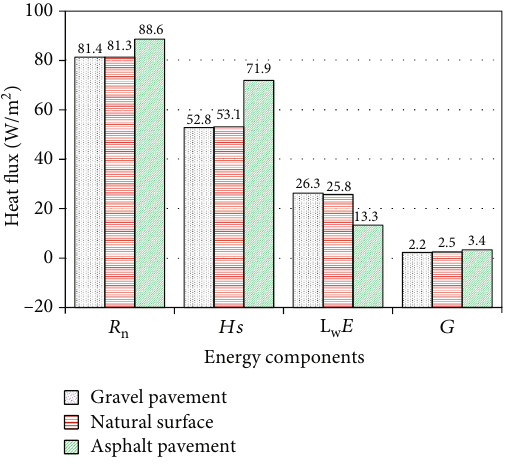
Figure 4: The annual average value of energy components at di ff erent underlying